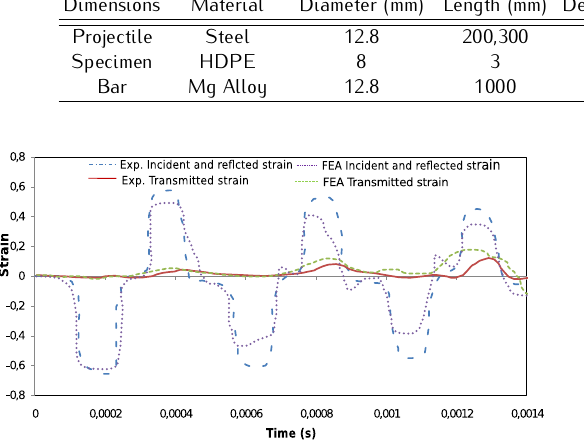
Figure 7. The strain wave in incident and transmitter bars with HDPE specimen.